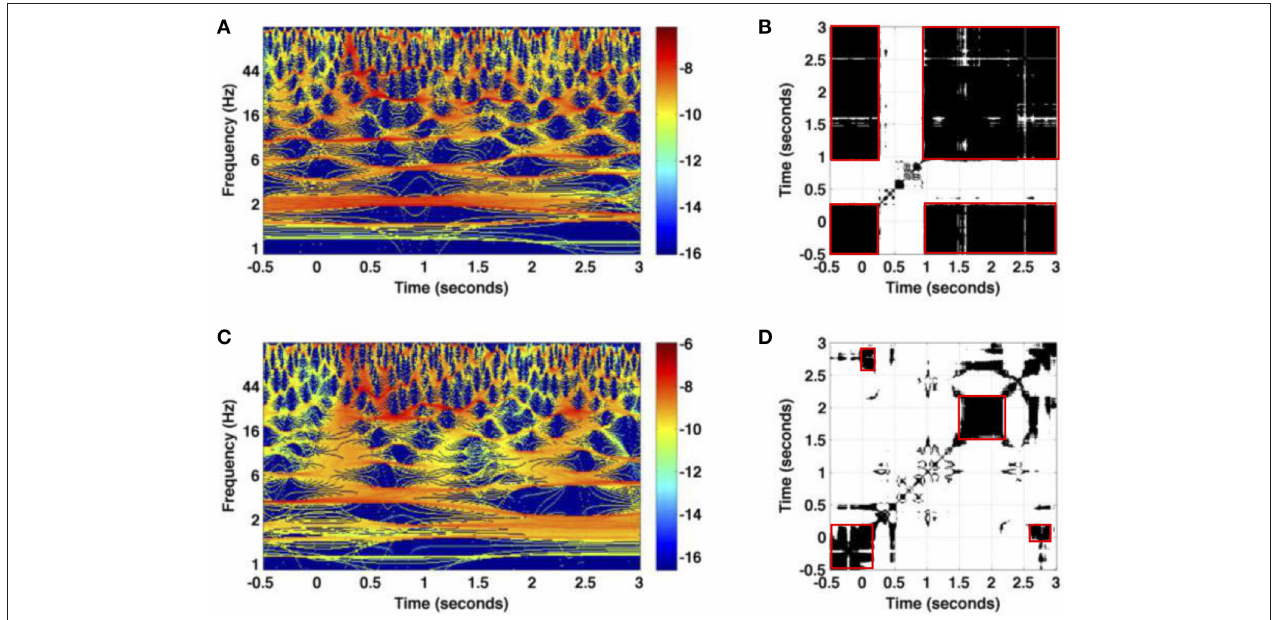
FIGURE 6 | Illustration of trial variability for the experimental dataset session one . (A,C) The logarithm values of the power spectrum for two trials measured at an electrode in the granular layer; (B,D) the corresponding recurrence plots. Non-zero values of recurrence plots are encoded in black. Red boxes denote recurrent metastable